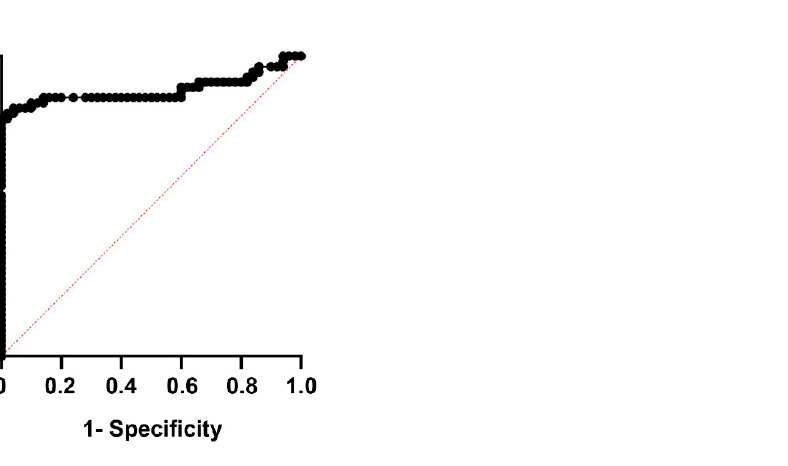
Figure 2. Receiver operating characteristic (ROC) curve showing the predictive power of AM levels on whether experimental subjects belong in the healthy or disease groups. The area under the curve (AUC) was 0.89, with 80.0% sensitivity and 100% specificity ( p < 0.0001).